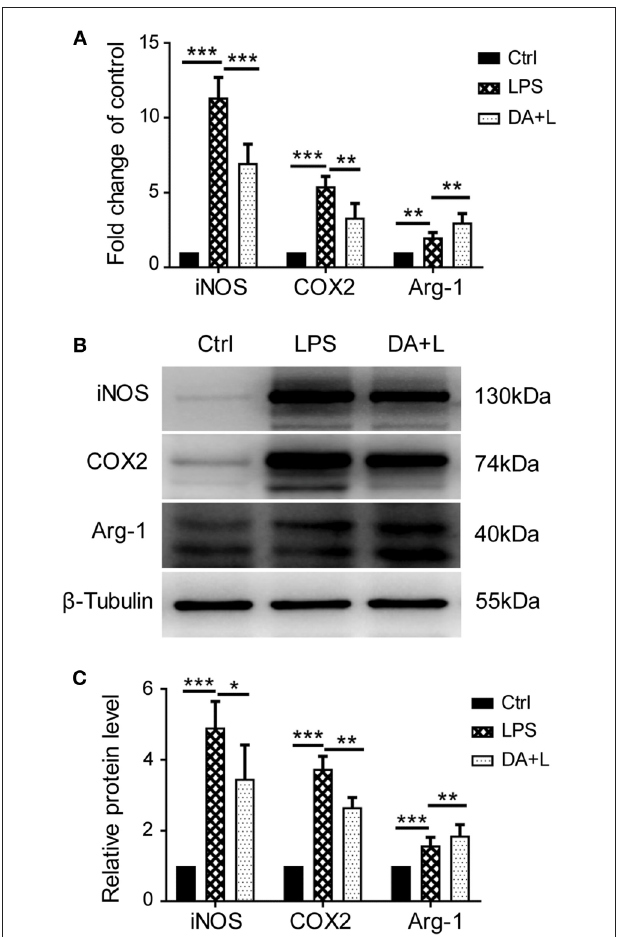
FIGURE 2 | Notch1 signaling regulated retinal microglia polarization in vitro . (A) The mRNA expressions of M1 phenotype-specific markers (iNOS and COX2) and M2 phenotype-specific marker (Arg-1) were markedly increased in the primary cultured retinal microglia by LPS stimulation compared with the control. DAPT pretreatment suppressed the expressions of iNOS and COX2, but further enhanced Arg-1 expression. (B,C) The protein expressions of iNOS, COX2 and Arg-1 were consistent with the results of mRNA expression. * p < 0.05, ** p < 0.01, and *** p < 0.001 (one-way ANOVA). Ctrl, Control; DA + L, DAPT +